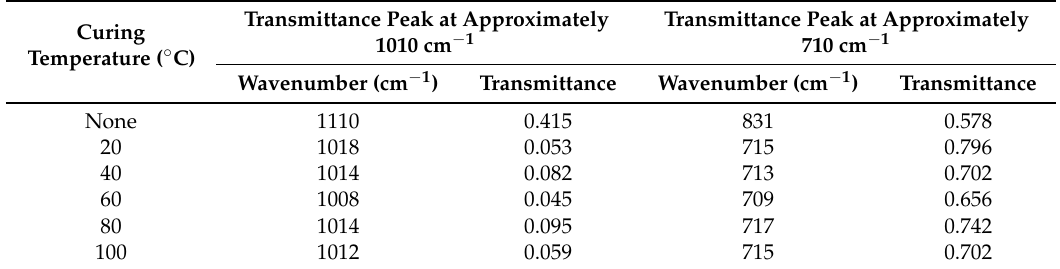
Table 5. Detailed data about the transmittance peak approximately 1010 cm − 1 and 710 cm − 1